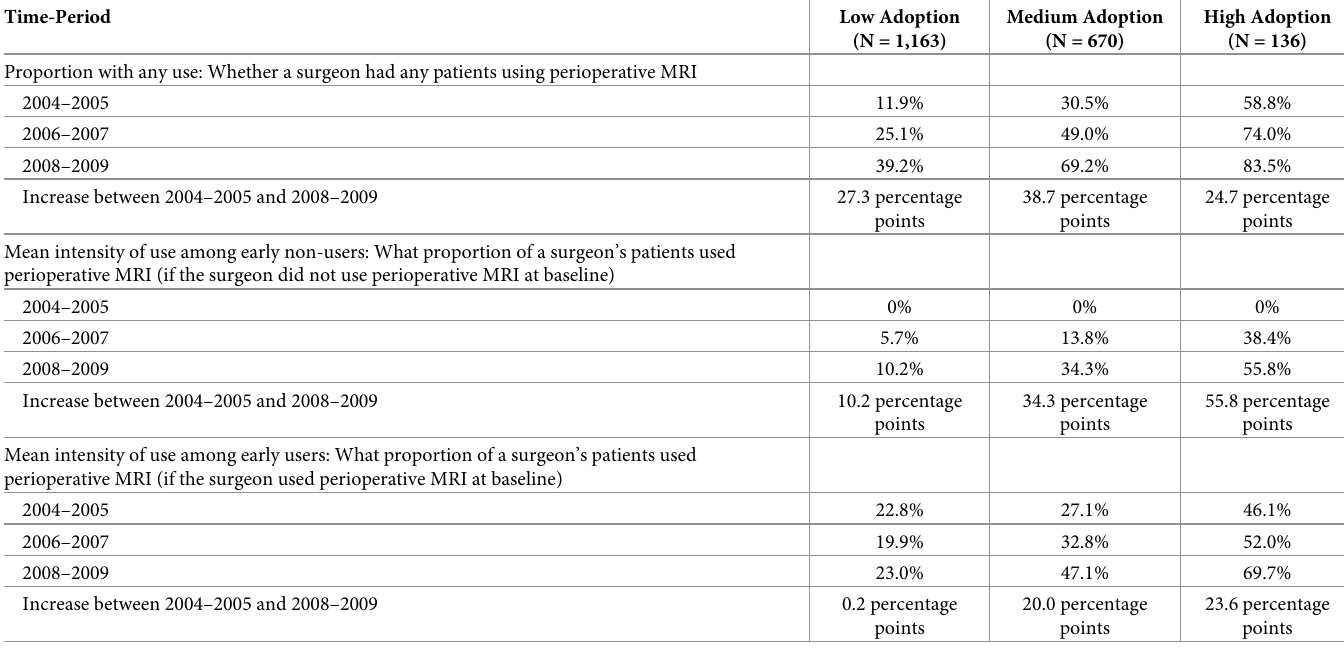
Table 3. Changes in the proportion of surgeons using perioperative MRI and intensity of utilization over time across the distinct trajectories (N = 1,969 surgeons). Time-Period